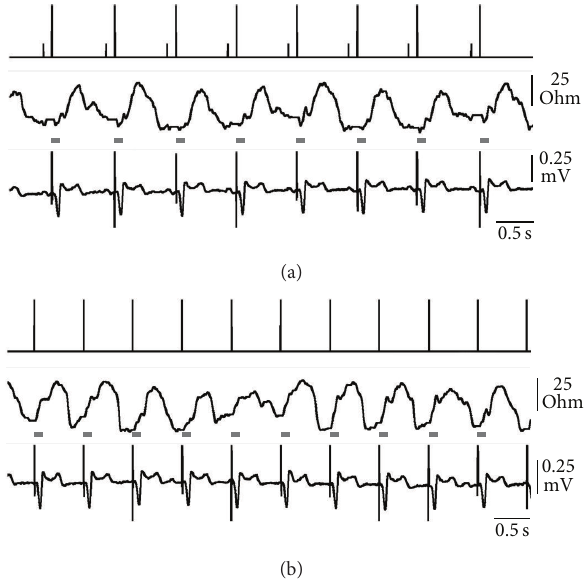
Figure 1: Real-time telemetry from the implanted pacemaker. Event markers (upper tracing; short bar = atrial sensing; long bar = ventricular pacing) and transvalvular impedance (TVI; middle tracing; recording in ventricular tip configuration) are matched with the surface ECG (lead II; lower tracing). The horizontal grey bars represent the TVI blanking period following the ventricular spike emission. Atrium-driven (a) and VVI stimulation (b) are compared in the same